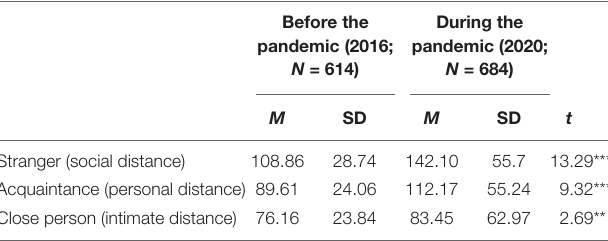
TABLE 5 | Preferred physical distances before/during the COVID-19 pandemic.